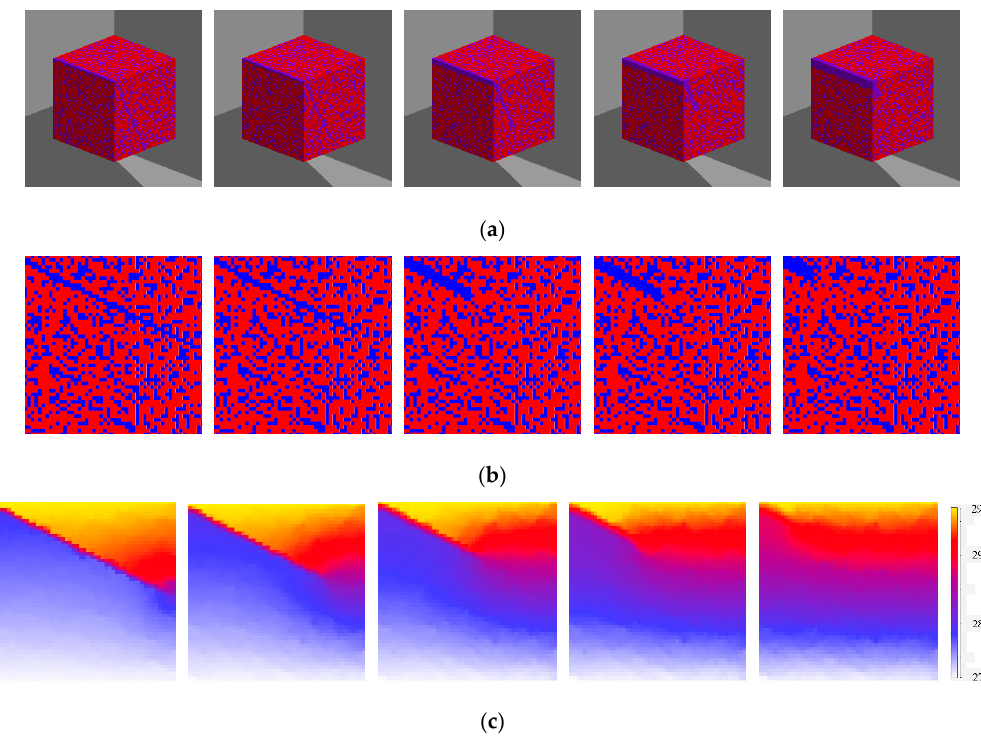
Figure 5. Digital rocks with tilted fractures (30°): ( a ) digital rocks, ( b ) 2D slices, and ( c ) temperature distribution.